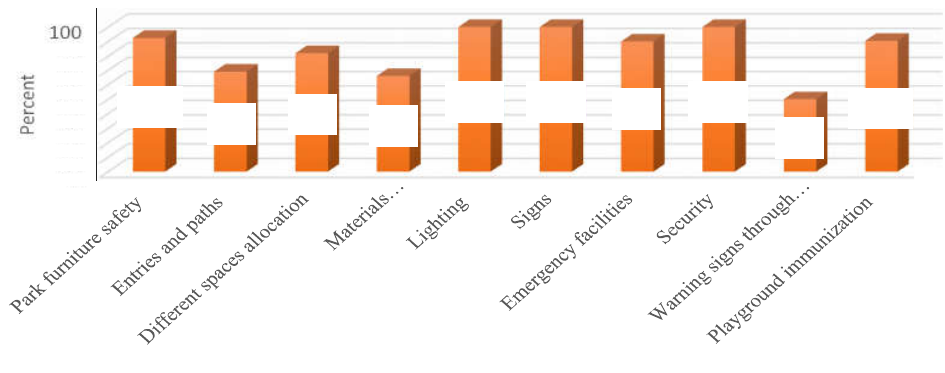
Fig. 4: Average percentage of safety indexes